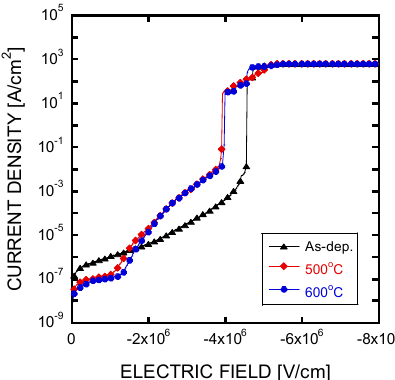
Figure 9. Current–voltage characteristics of ALD-based ZrO 2 using CMEN-Zr and oxygen plasma as zirconium and oxygen sources, respectively: ( a ) as-deposited, ( b ) annealed at 500 °C, and ( c ) annealed at 600 °C.